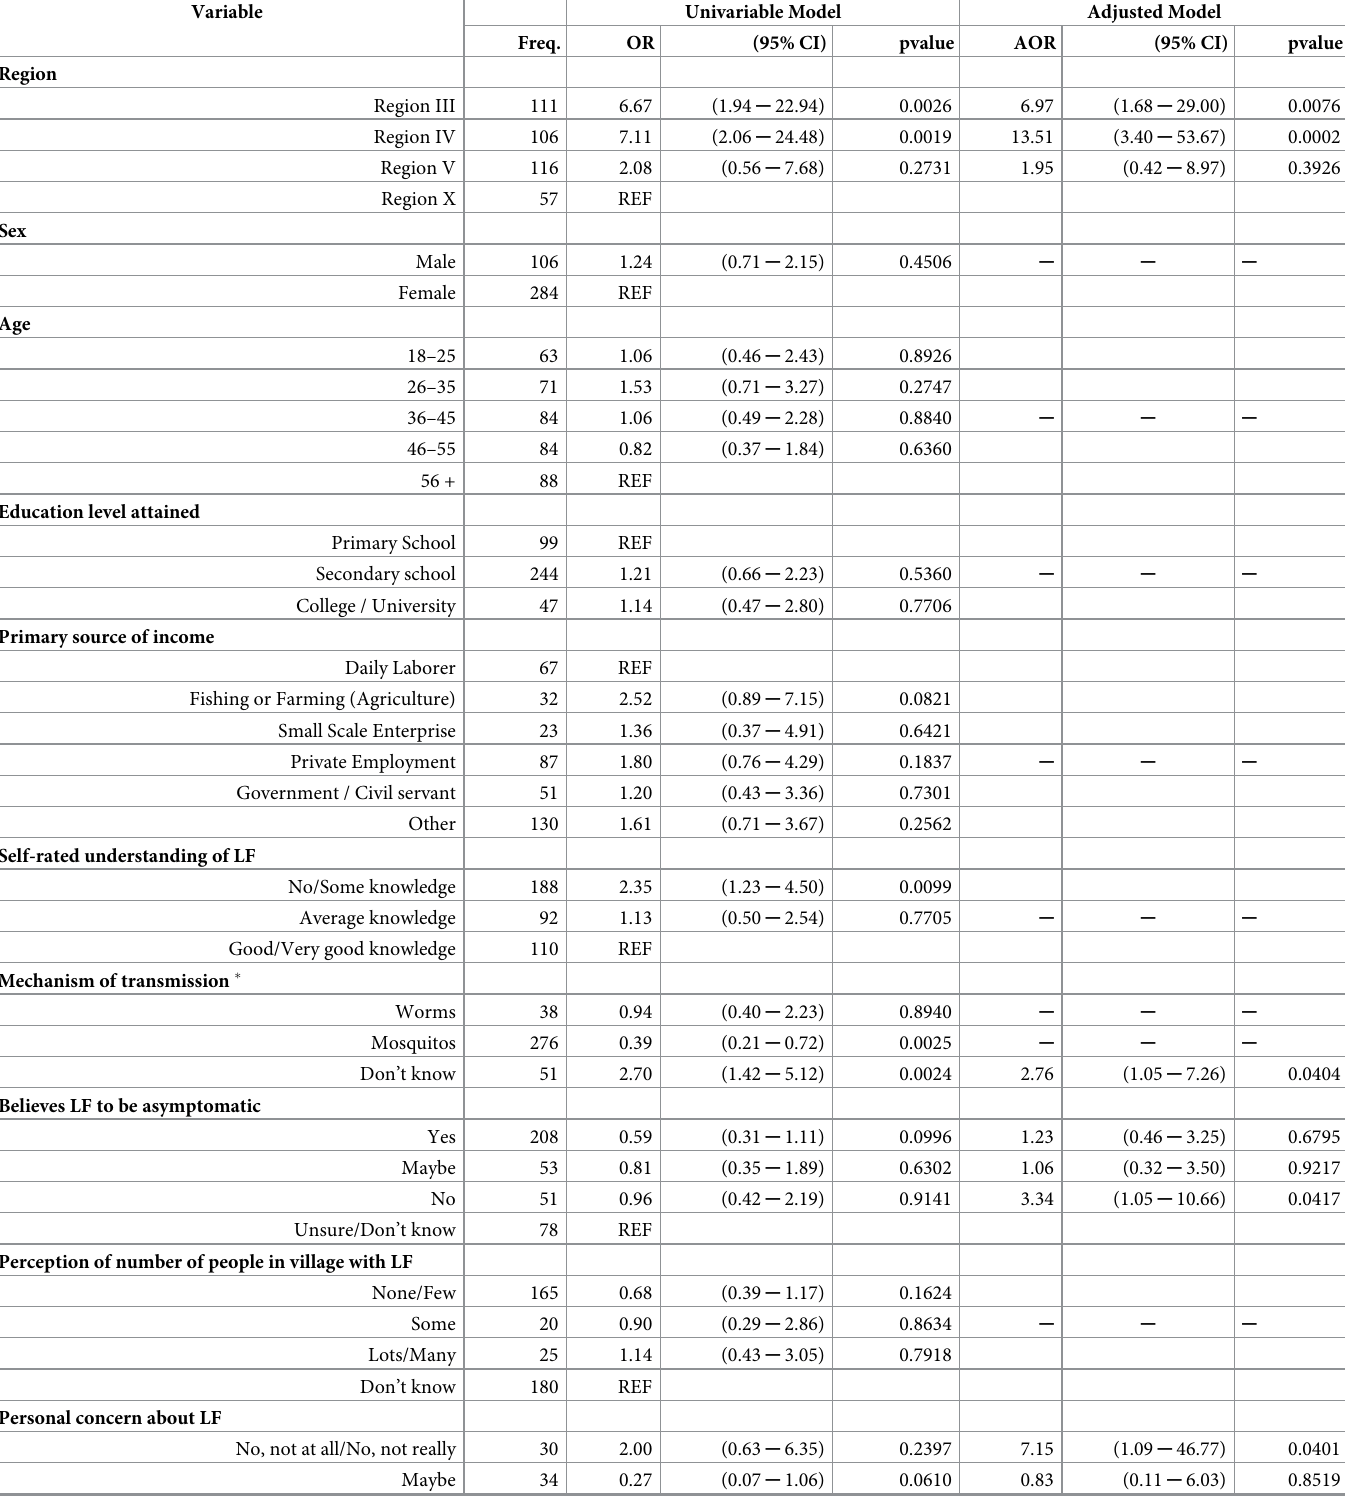
Table 6. Univariable and adjusted logistic regression predicting odds of systematic non-compliance (never treated) with MDA in the primary study